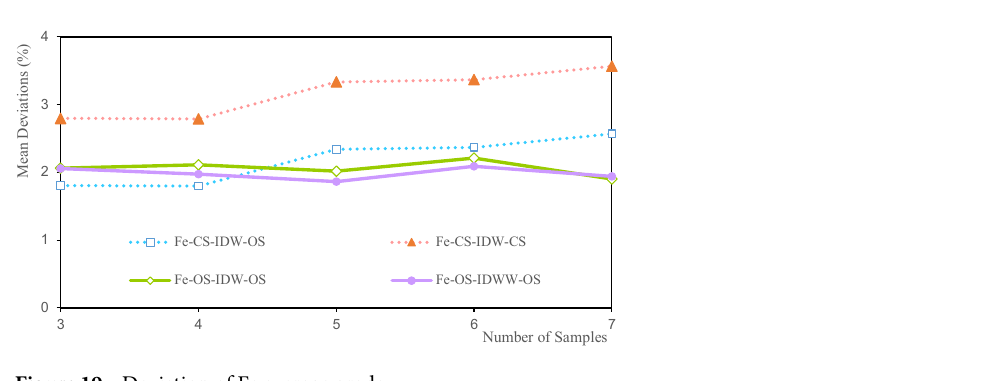
Figure 19. Deviation of Fe average grade.